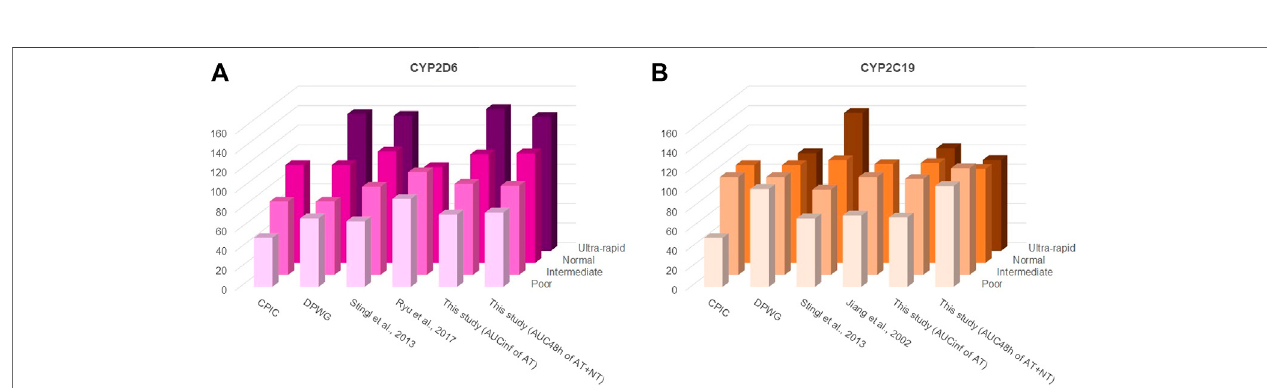
FIGURE 8 | Different starting dosage adjustment recommendations from the literature and based on the results of this study for (A) CYP2D6 and (B) CYP2C19. These were taken from the Clinical Pharmacogenetics Implementation Consortium (CPIC ® ) guideline (Hicks et al., 2017), the Dutch Pharmacogenetics Working Group (DPWG) guideline (August 2019 update), or calculated based on the formulas described by Stingl et al. (2013) and by using the AUCs determined in the respective studies. In accordance with the CPIC ® and DPWG fi nal consensus on CYP2D6 genotype to phenotype (Caudle et al., 2020), a CYP2D6 activity score of 0 was classi fi ed in this study as poor, of 0.5 and 1 as intermediate, of 1.5 and 2.0 as normal/extensive, and of > 2.5 as ultra-rapid metaboliser phenotypes. For CYP2C19, an activity score of 0 was classi fi ed in this study as poor, of 1 as intermediate, of 1.5 and 2 as normal/extensive, and of > 2 as ultra-rapid metaboliser phenotypes.